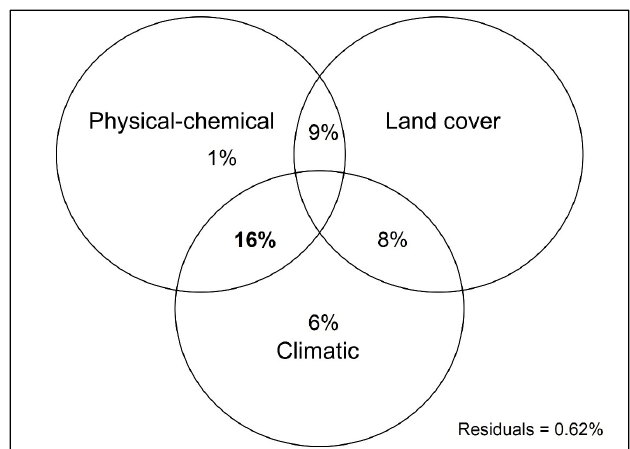
Figure 5. Redundancy analysis (RDA) ordination plot illustrating the key driving factors (after eliminating less important variables) of mollusc communities in each cluster. Each number represents each cluster of sites.